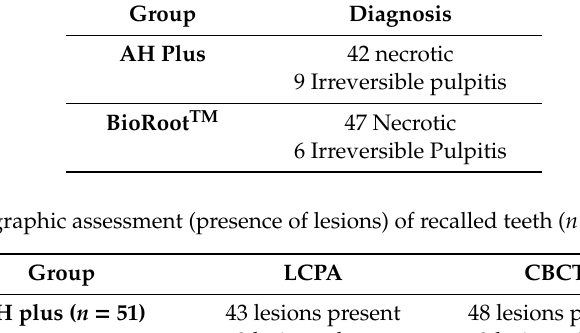
41 lesions present 7 lesions absent LCPA, long cone periapical; CBCT, cone beam computed